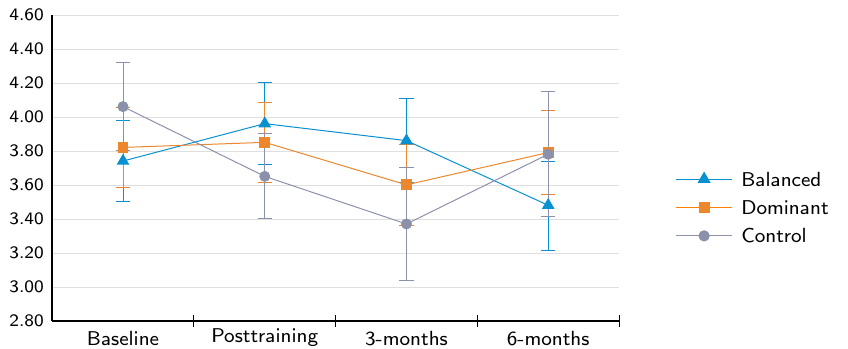
Figure 2. Estimated marginal means for health goal striving between groups across time. Error bars represent standard errors.